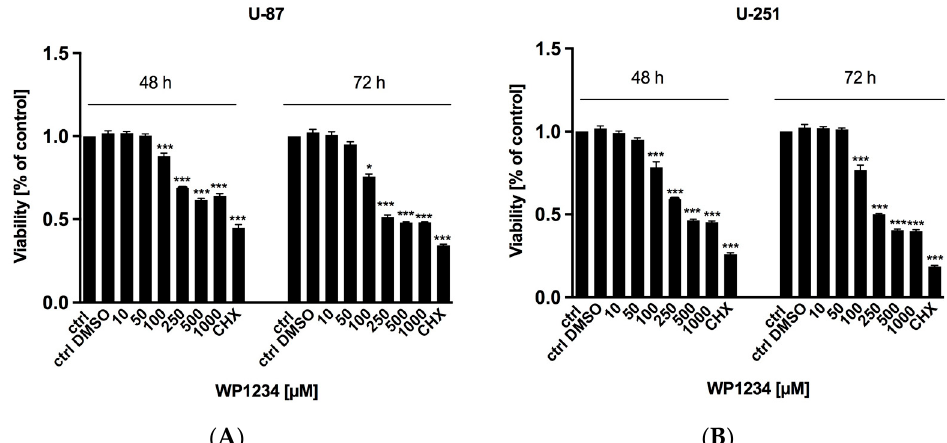
Figure 2. MTS assay showing the viability of ( A ) U-87 and ( B ) U-251 cells after 48 and 72 h treatment with various concentrations of WP1234 (10–1000 μ M). As a reference cytotoxic agent, CHX (20 μ M) was used. Significant differences between the treatment and control (untreated cells) means are indicated by * p < 0.05, ** p < 0.01, *** p < 0.001.